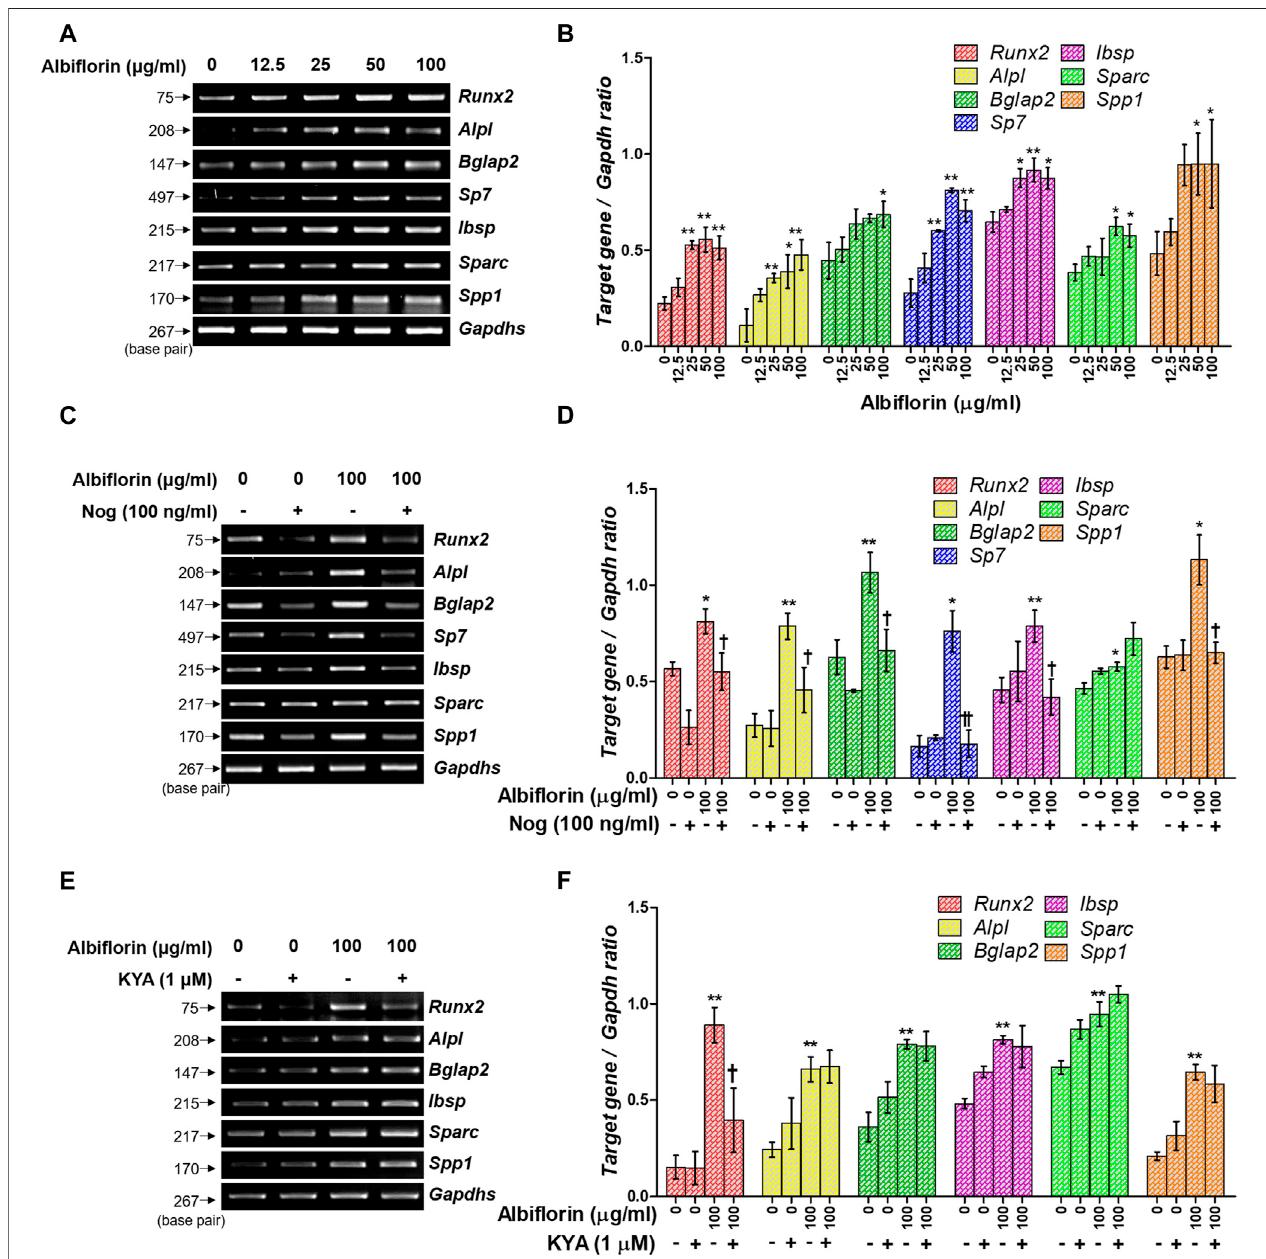
FIGURE 7 | Effect of albi fl orin on an osteogenesis-associated gene. (A) The Runx2, Alpl (ALP) , Bglap2 (OCN) , Sp7 (osterix) , Ibsp, Sparc (OSN) , and Spp1 (OPN) mRNA expression levels were detected using RT-PCR. (B) Each mRNA was quanti fi ed with respect to that of Gapdhs . (C) The BMP-2 inhibitor noggin was used for treatmentwithorwithoutalbi fl orin. (D) TheexpressionofallmRNAwasnormalizedtothatof Gapdhs . (E) TheWnt/ β -catenininhibitorKYA1797Kwasusedfortreatment with or without albi fl orin (F) The expression of all mRNA was quanti fi ed with respect to that of Gapdhs. These results are presented as the mean ± SEM ( n (cid:2) 3 for each experimental). ** p < 0.01, * p < 0.05 vs. osteogenic medium cells. †† p < 0.01, † p < 0.05 vs. 100 μ g/ml ablbi fl orin-treated cells.